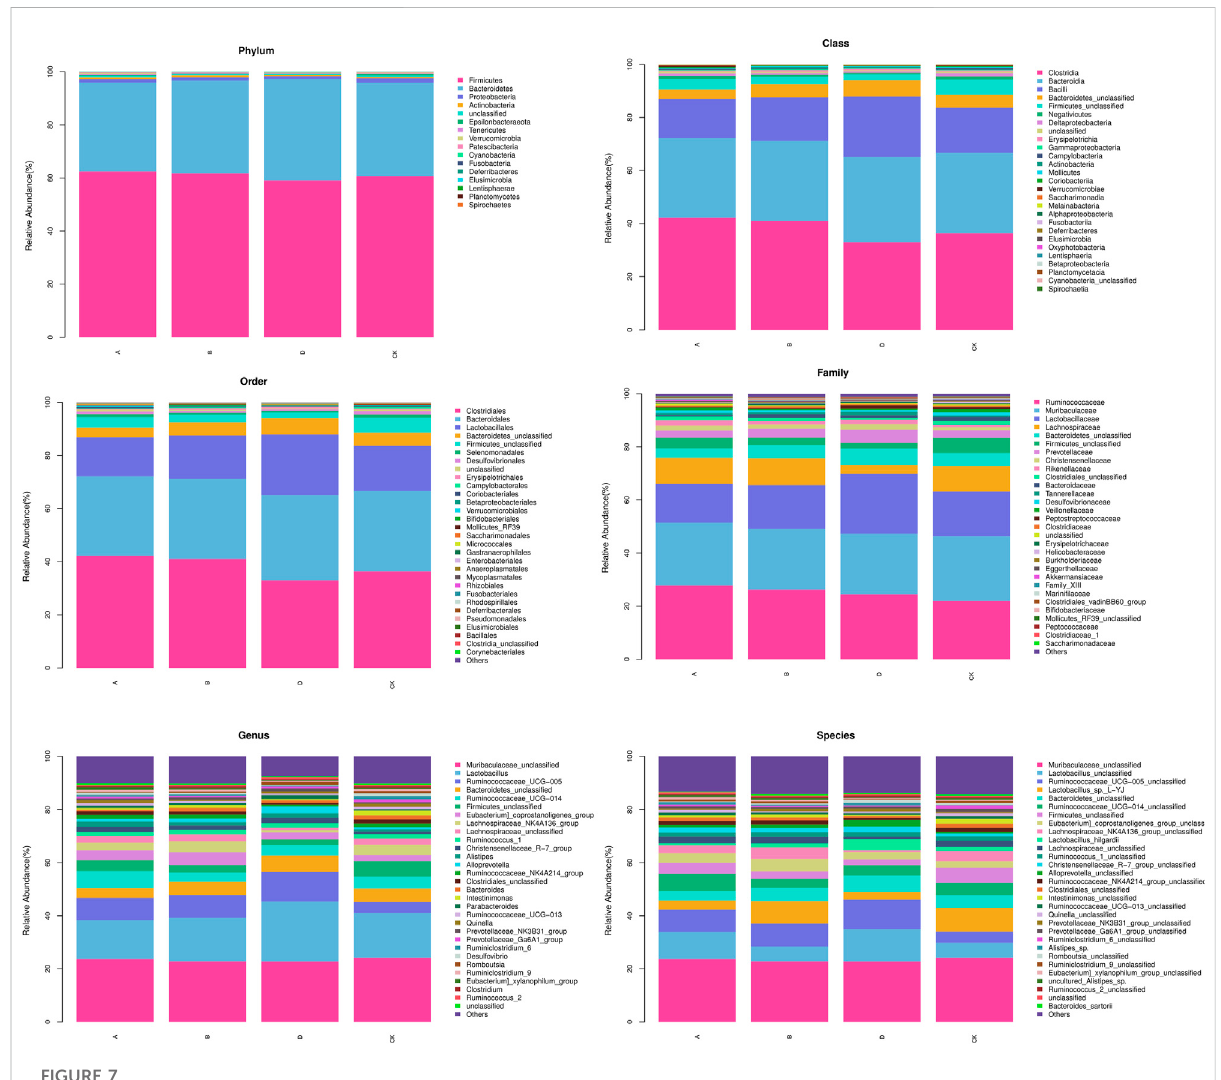
FIGURE 7 Abundance clustering of each group. A, L-APS; B, M-APS; CK, H-APS; D,